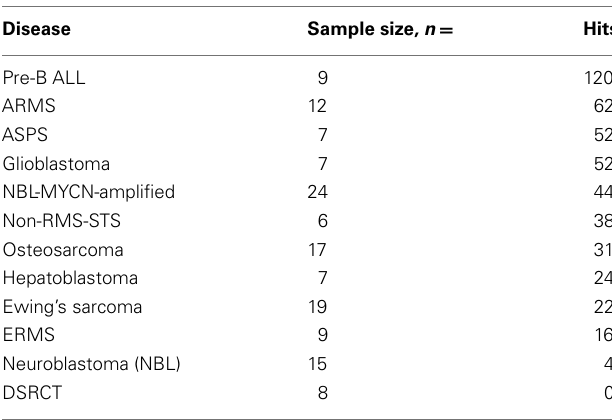
value greater than 10.